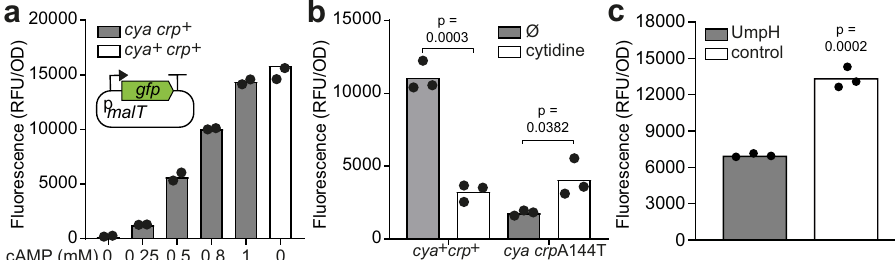
Fig. 5 In vivo pyrimidine effects on Crp and CrpA144T determined with a sensitive Crp reporter. a Illustration and validation of an in vivo Crp activity reporter based on a plasmid with the P malT promoter controlling expression of gfp . The reporter was transformed into a cya strain, and fl uorescence was detected in the presence of different concentrations of cyclic adenosine monophosphate (cAMP). A cya + strain served as a positive control (white). Data represent the average of two biological replicates. b The effect of exogenously added cytidine (white) on the Crp activity reporter in a wildtype ( cya + crp + ) or mutant ( cya crp A144T) strain background. No supplementation (grey, Ø) serves as a negative control. Data represent the average of three biological replicates. c Effect of overexpression?- P of umpH (grey), compared to empty vector control (white), in wildtype E. coli K12 MG1655 assayed with the GFP reporter. Data represent the average of three biological replicates. Signi fi cance was based on two-sided unpaired t-tests between the groups indicated, and designated as signi fi cant if p < 0.05. RFU, relative fl uorescence units; OD,